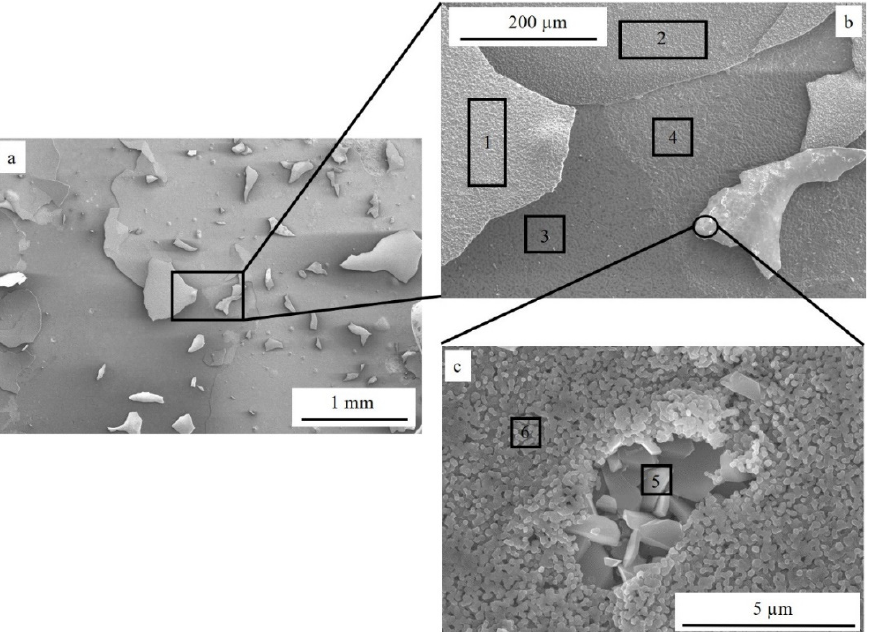
Figure 5. Secondary electron images of the surface of the Ti-coated sample after 100 h aging at 800 °C under laboratory air: ( a ) global view, ( b ) magnification of a spalled zone, and ( c ) magnification of spalled TiO 2 scale upside down.